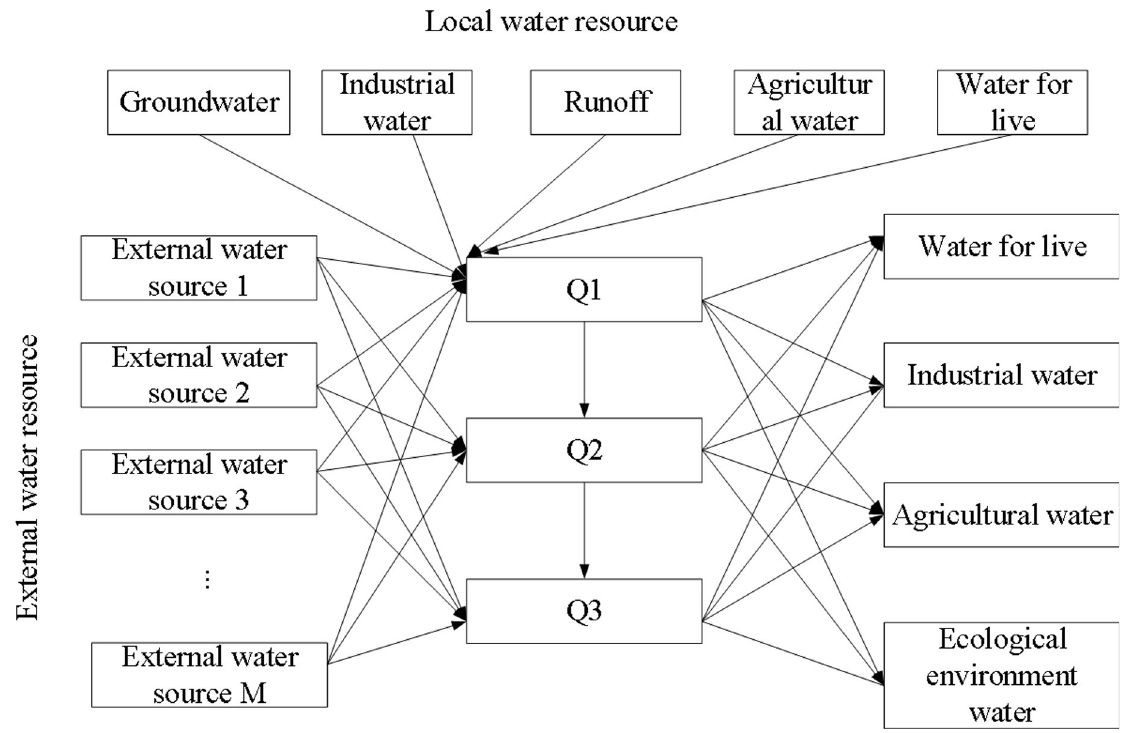
Fig 2. Water resource allocation